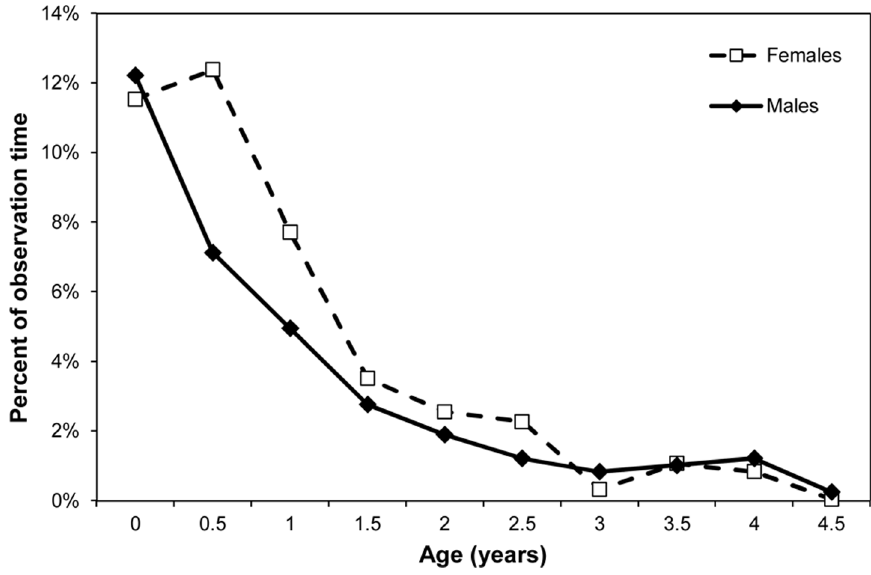
Figure 3. Mean percent of observation time spent riding ventrally for male and female infants.